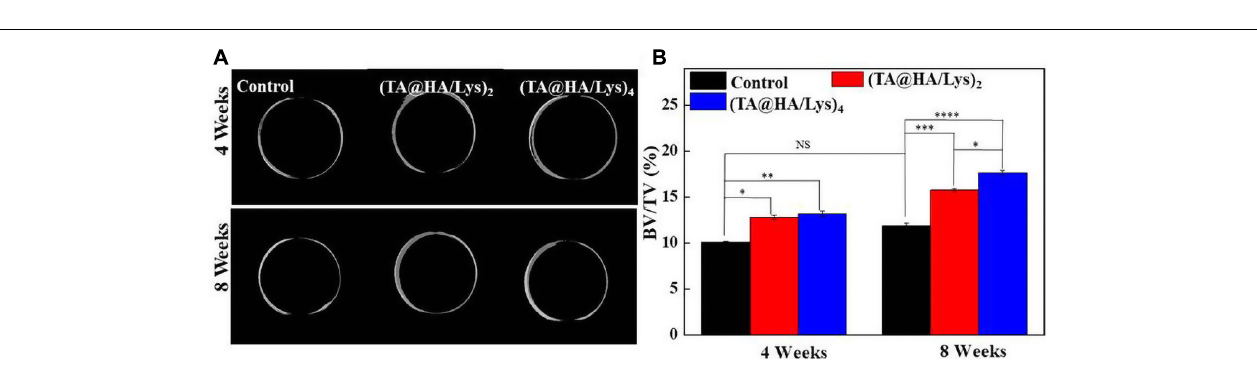
FIGURE 9 | Expressions of genes in relation to osteogenic differentiation for DPSCs being inductively cultured on the (TA@HA/Lys) 2 and (TA@HA/Lys) 4 substrates and glass coverslips as control: (A) runt-related transcription factor 2 (Runx2), (B) osteonectin (ON), and (C) osteocalcin (OCN). ** p < 0.01, **** p < 0.0001.